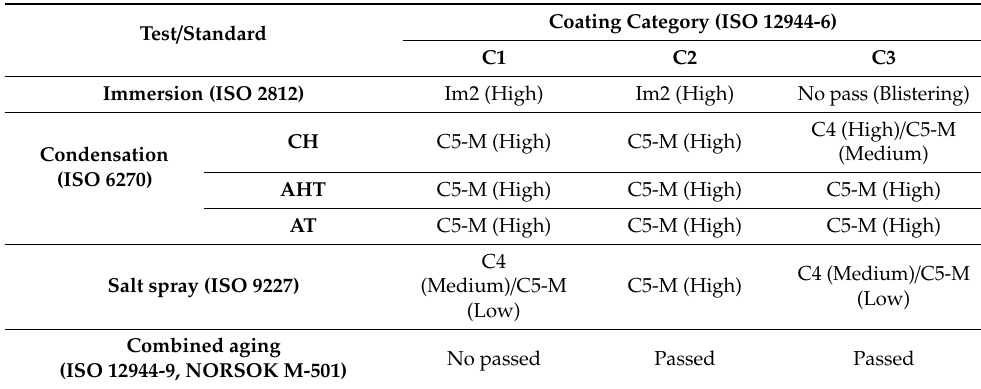
Table 8. Summary of the corrosivity categories of the ISO 12944-6 [15] standard obtained for the three coatings in all the weathering aging tests